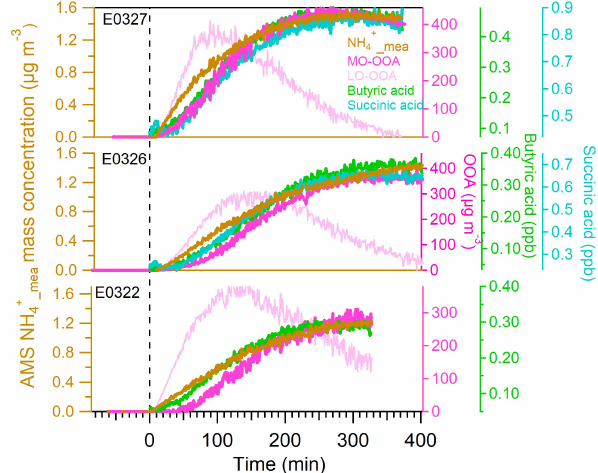
Figure 6. Correlations of the ammonium attributed to the neutralization by organic acids (NH + the (a) formic acid, (b) acetic acid, (c) propionic acid and (d) pinonic acid in the gas phase measured by PTRMS in the nucleated SOA experiments (left four panels) and in the seeded SOA experiments (right four panels). The light pink area in (d1) indicates a nonpositive correlation regime between two species.